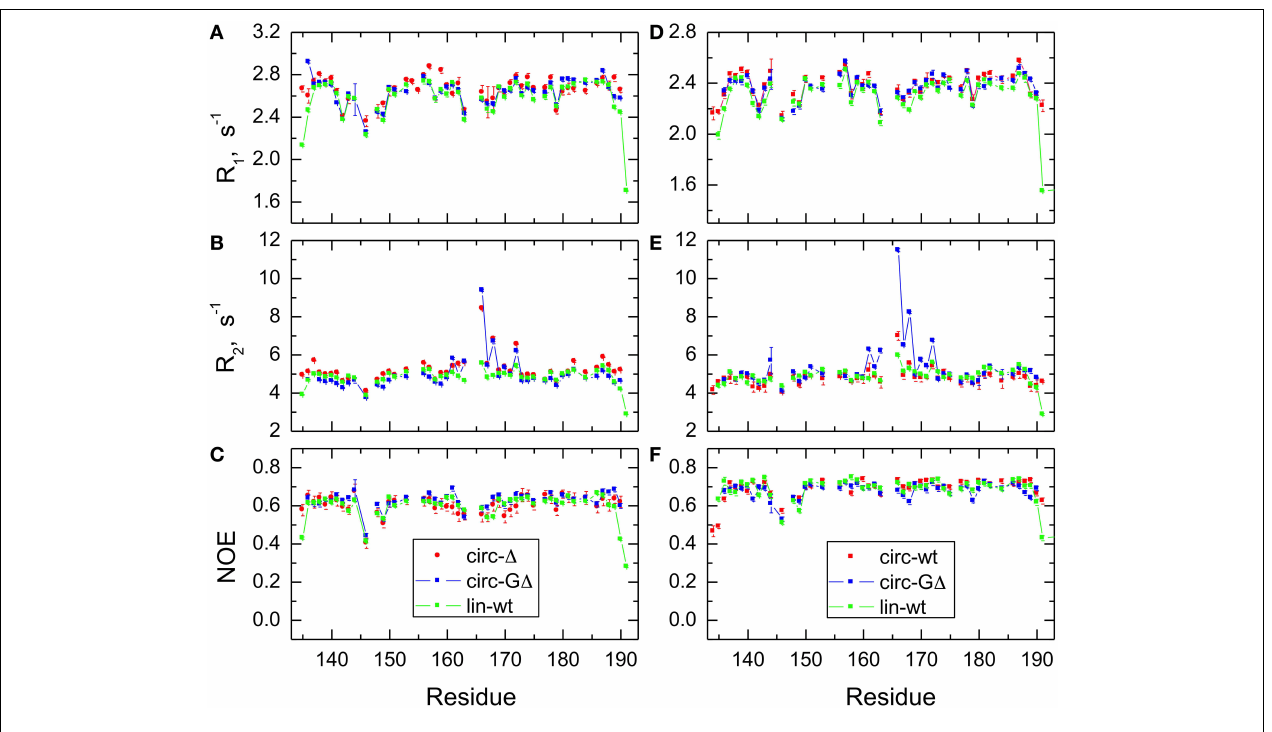
circles), SH3 circ - G 1 (blue), and SH3 lin - wt (green) and at 600 MHz (D–F) for SH3 circ - G 1 (blue), SH3 circ - wt (red squares), and SH3 lin - wt